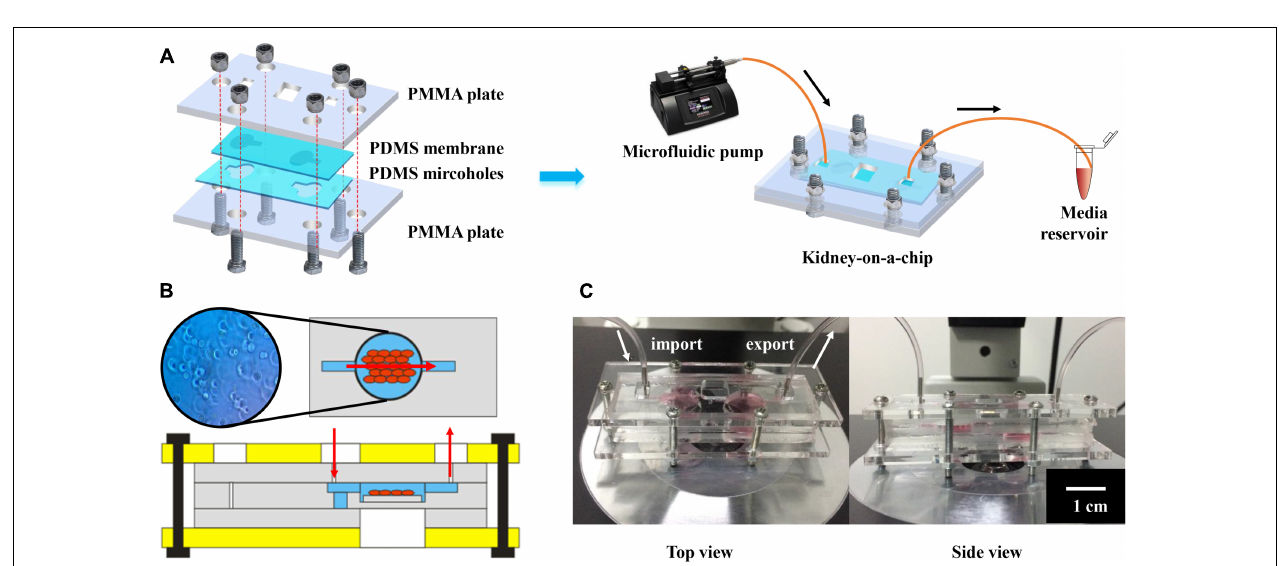
FIGURE 5 | The scheme of GelMA preparation and cell encapsulation. Gelation involved methacrylation to form GelMA, and cross-linking under PI catalysis and exposure of UV light. Cells are encapsulated in the hydrogel and cultured in 3D.